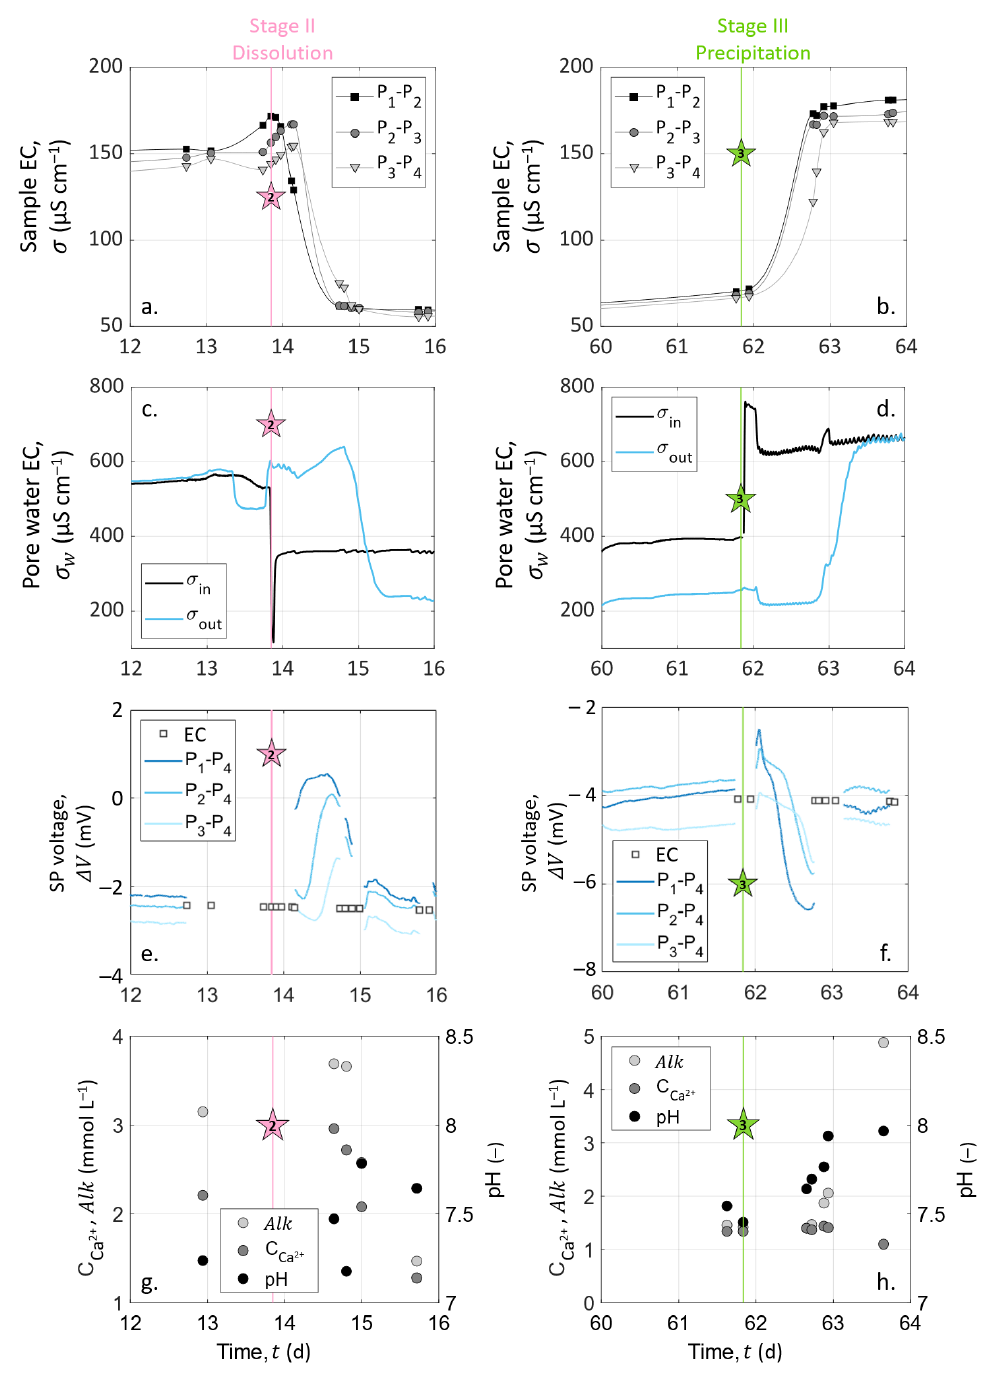
Figure 5. Zoomed views of Figure 4 centered on Events 2 and 3. ( a , b ) Sample EC measured on three channels of acquisition corresponding to different dipoles of potential electrodes. ( c , d ) Inlet and outlet pore water EC. ( e , f ) SP curves measured on three channels of acquisition corresponding to different dipoles of potential electrodes, using electrode P 4 as the reference. The white squares represent the interruption of SP acquisition to measure sample EC instead. ( g , h ) Calcium concentration, alkalinity, and pH